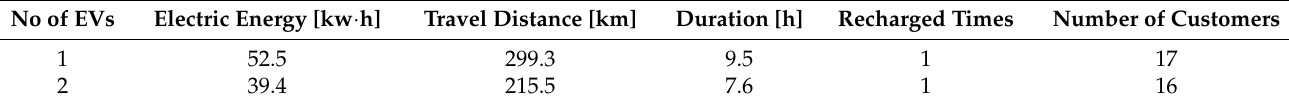
Figure 7. Distributions of customers, Hiland Dairy, and Charging stations in Dallas, TX, USA.